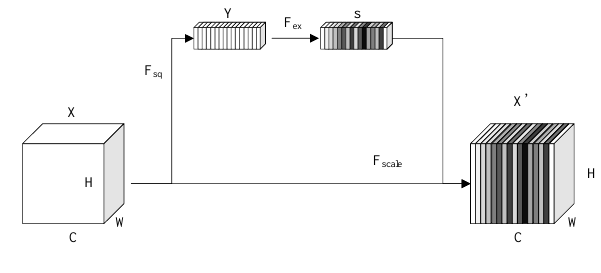
Figure 2 . Channel